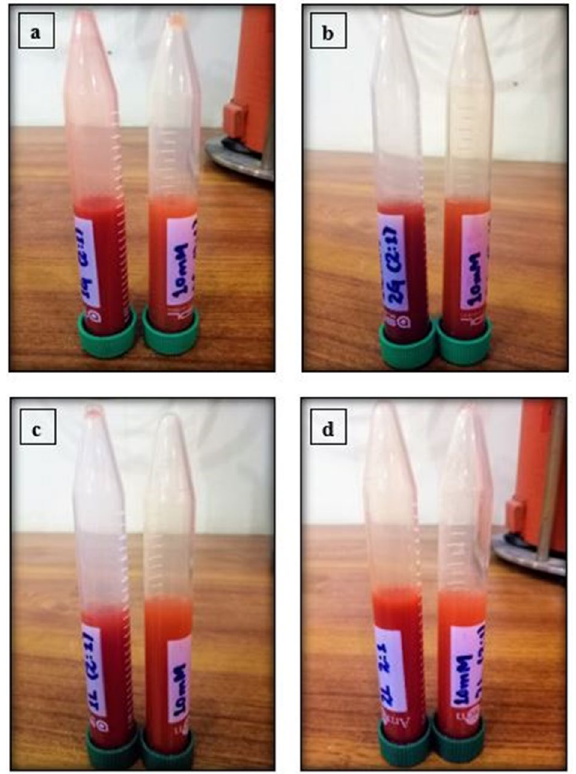
Figure 1. SeNPs synthesized from citrus fruit extracts; ( a ) from Citrus paradisi fresh juice extract, ( b ) from Citrus limon Fresh juice extract, ( c ) from Citrus paradisi fresh peels extract and ( d ) from Citrus limon fresh peel